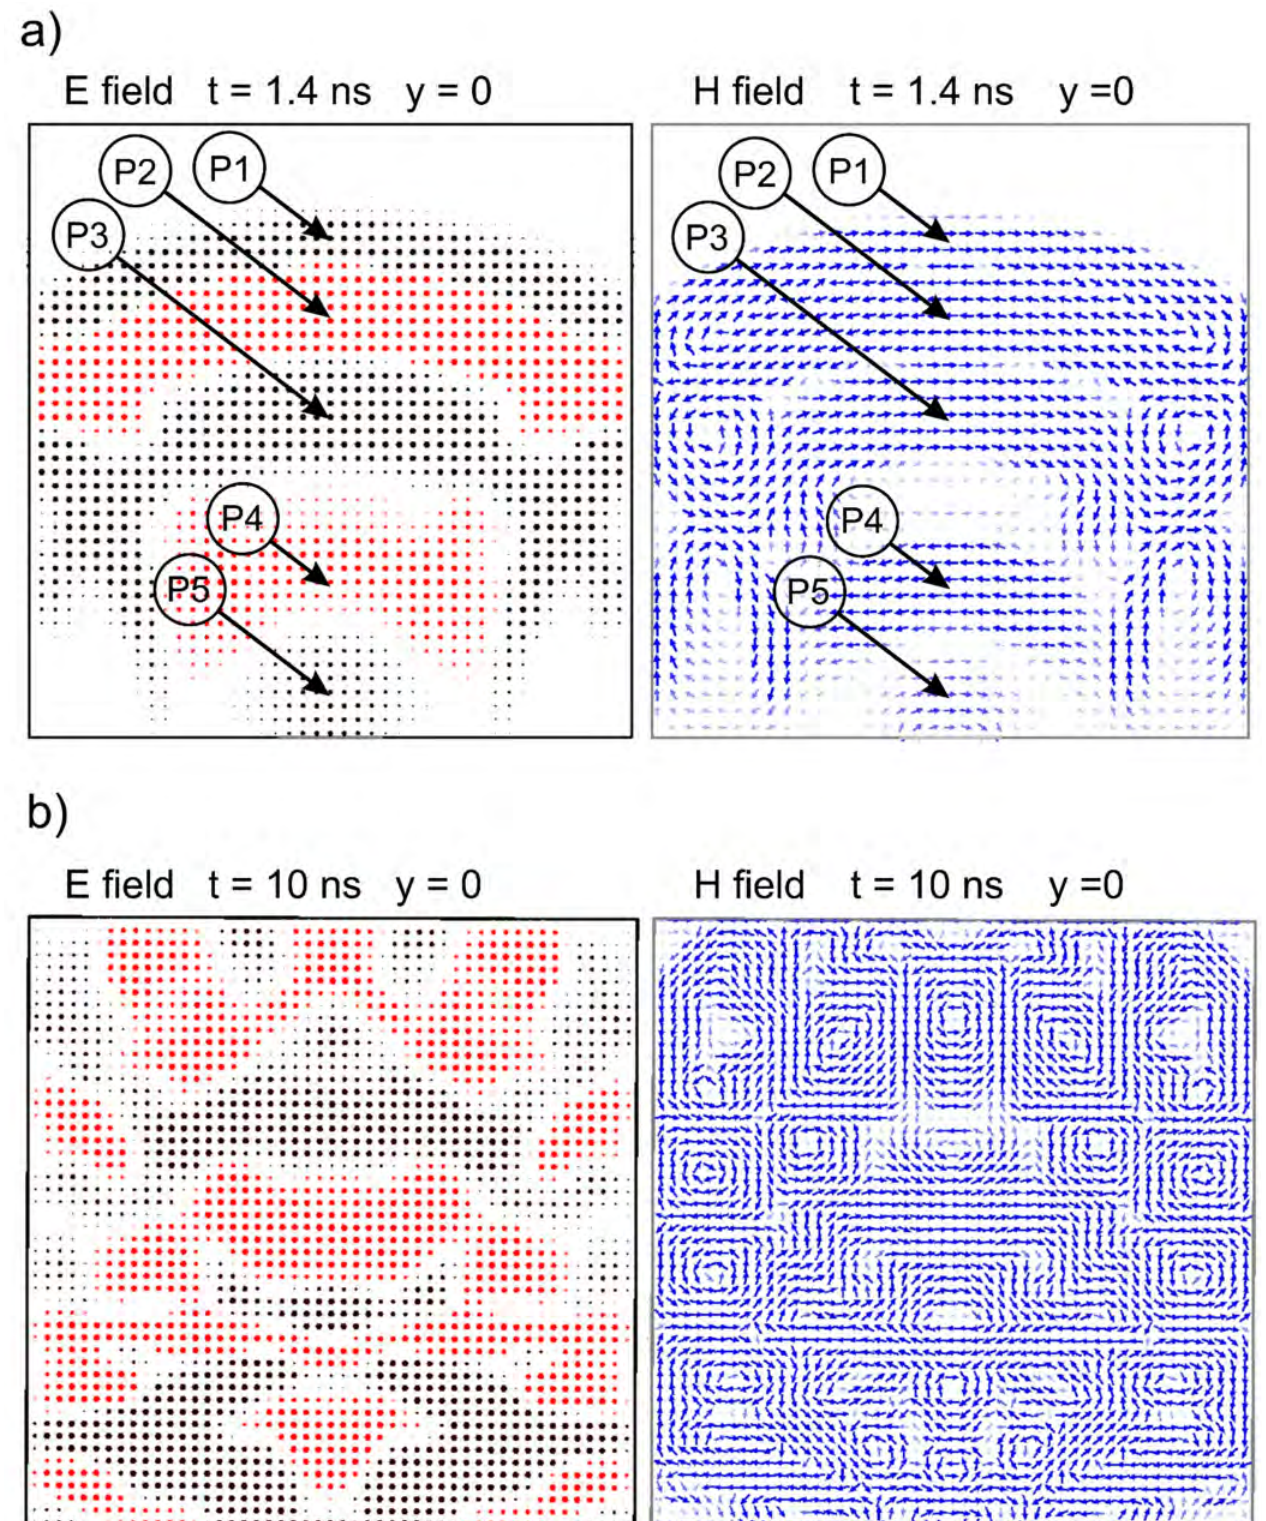
Figure 11. Electric and magnetic fields perpendicular to each other in the enclosure in the x–z plane (y = 0) at ( a ) t = 1.4 ns and ( b ) t = 10 ns. Note the symmetrical arrangement of the field patterns with respect to the z-axis (i.e., to the line aperture center—the rear wall). The electric field vectors are perpendicular to the plane y = 0. The electric field vectors are marked by black points when directed into the figure and light red when directed in the opposite